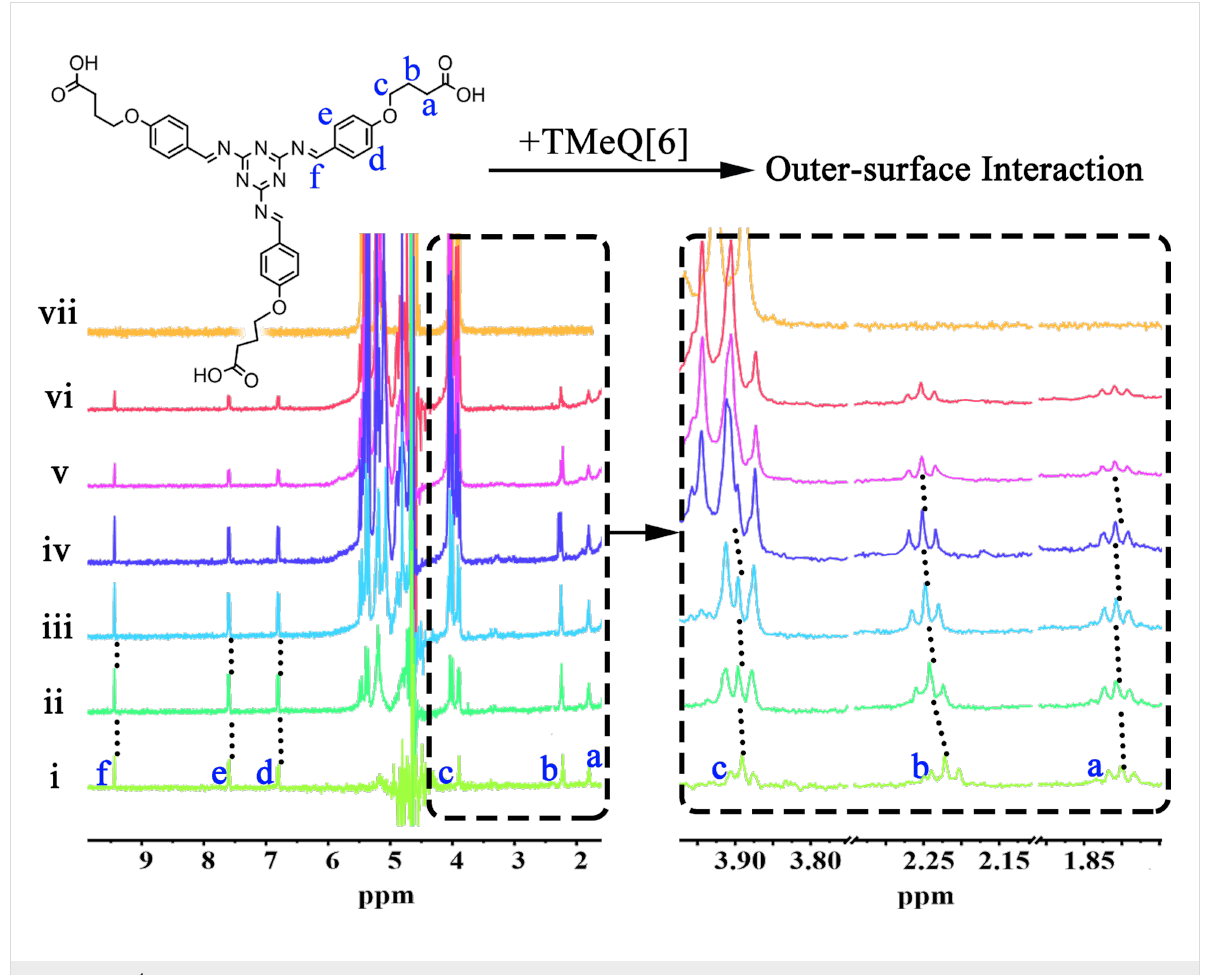
Figure 1: The 1 H NMR titration of TBT (1 mM) with an increasing amount of TMeQ[6] from 0 (i), 0.1 (ii), 0.2 (iii), 0.6 (iv), 1.0 (v) to 1.4 equiv (vi), and the 1 H NMR of free TMeQ[6] (vii) in D 2 O.